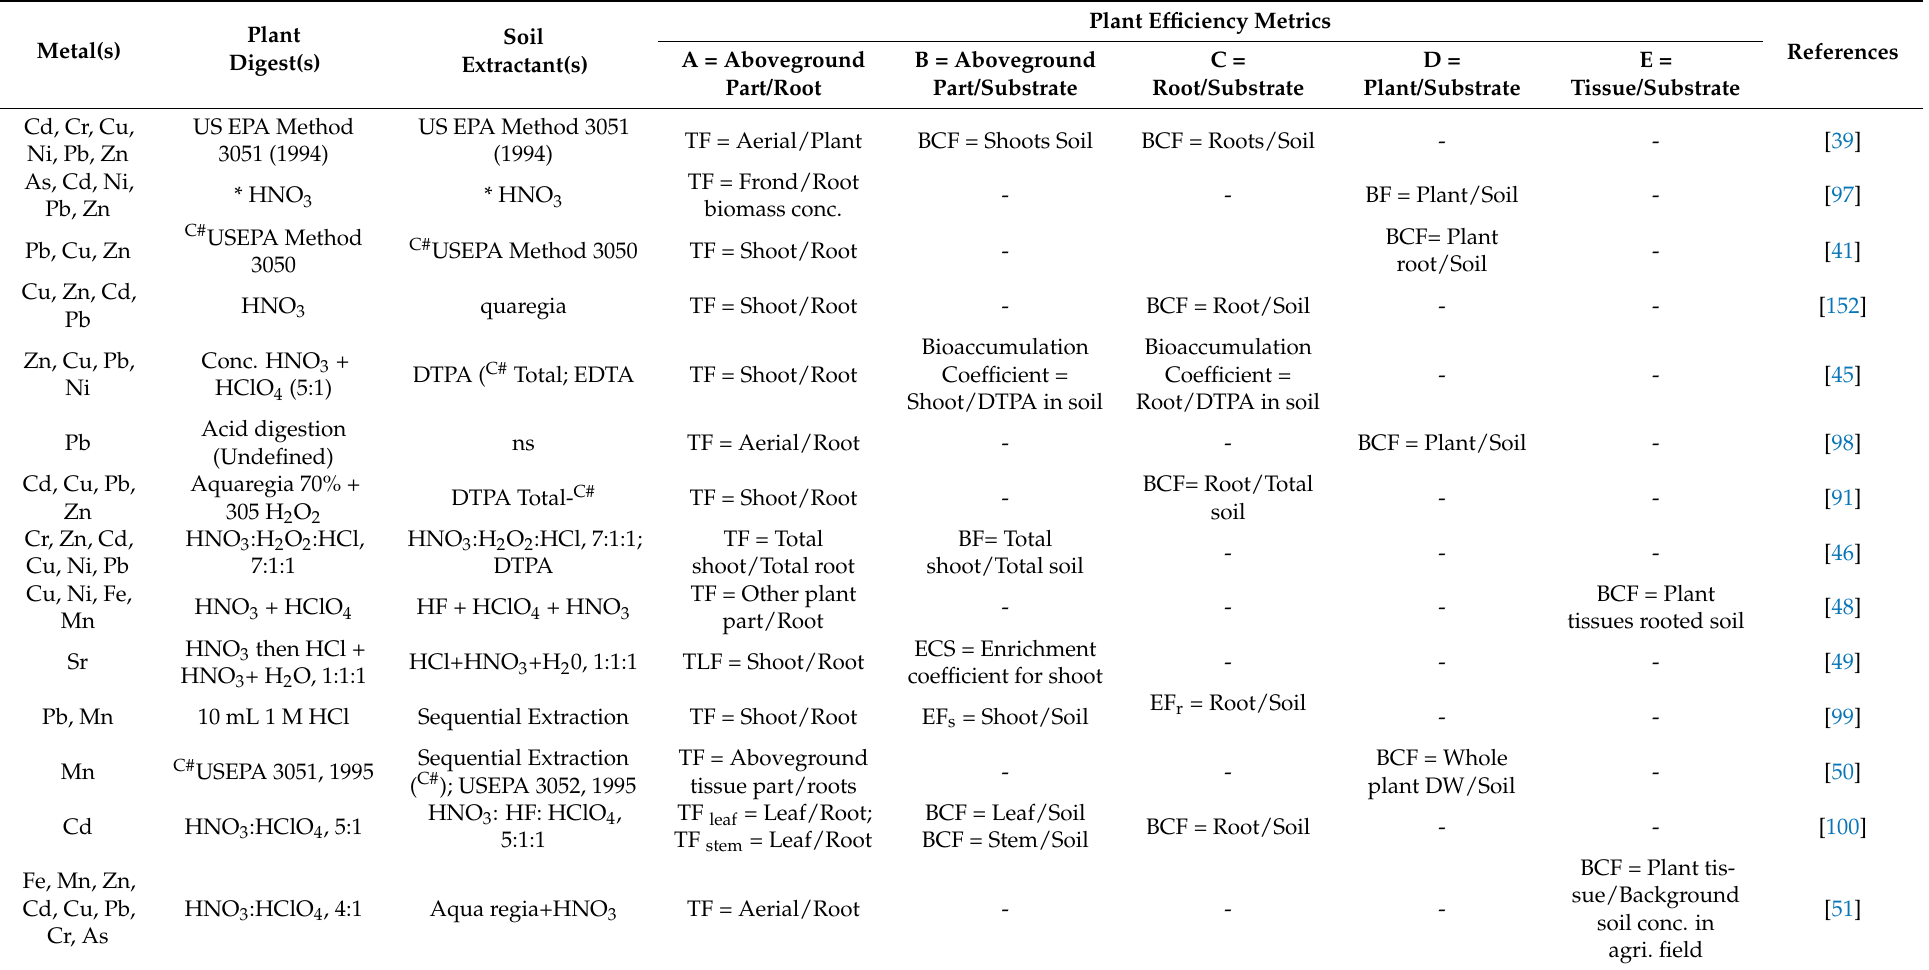
Table 4. List of plant and soil extractant, plant efficiency metrics to evaluate the remediation potential of naturally metal-contaminated